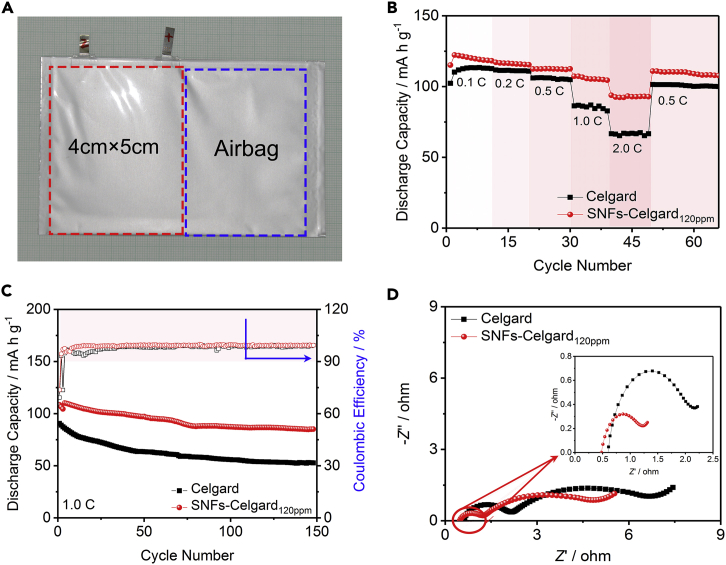
Electrochemical Performance of LiFePO4/Graphite Pouch Cells(A) Photograph of the pouch cell with the SNFs-Celgard120ppm separator.(B–D) (B) Rate performance, (C) cycling stability at 1.0 C (1.0 C = 133 mA h g−1), and (D) Nyquist plots after 150 cycles.